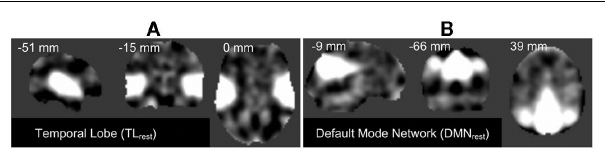
FIGURE 2 | Orthogonal views of the template images derived used by the proposed framework: (A) temporal lobe (TL rest ), and (B) default mode network (DMN) component images obtained from group-ICA on REST-fMRI data. The aggregate spatial components are presented here with the respective MNI